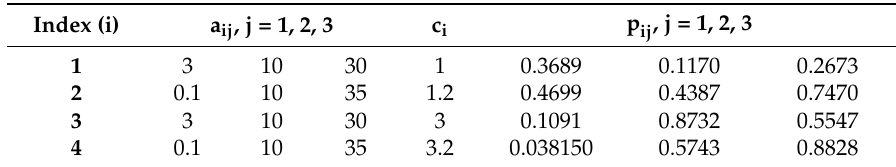
Table 6. Coefficients of Hartman’s Functions (F19).